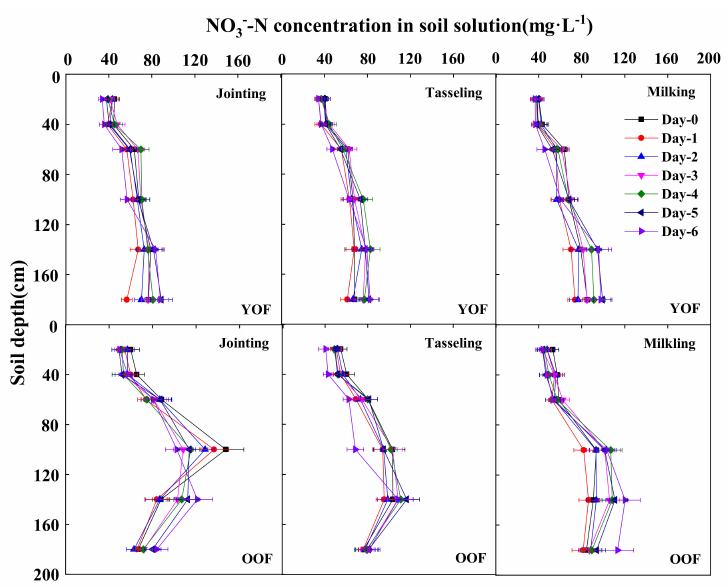
Figure 6. NO 3 − -N concentrations in soil solutions without N input measured at three crop growth stages during 2020. Error bars represent standard